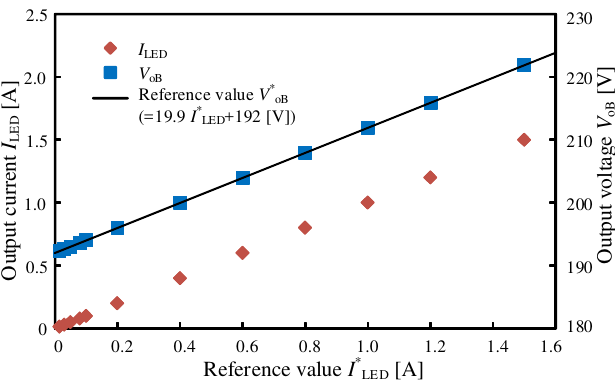
Figure 11. Simulation results of the output current I LED and voltage V oB for the reference LED current I ∗ . LED